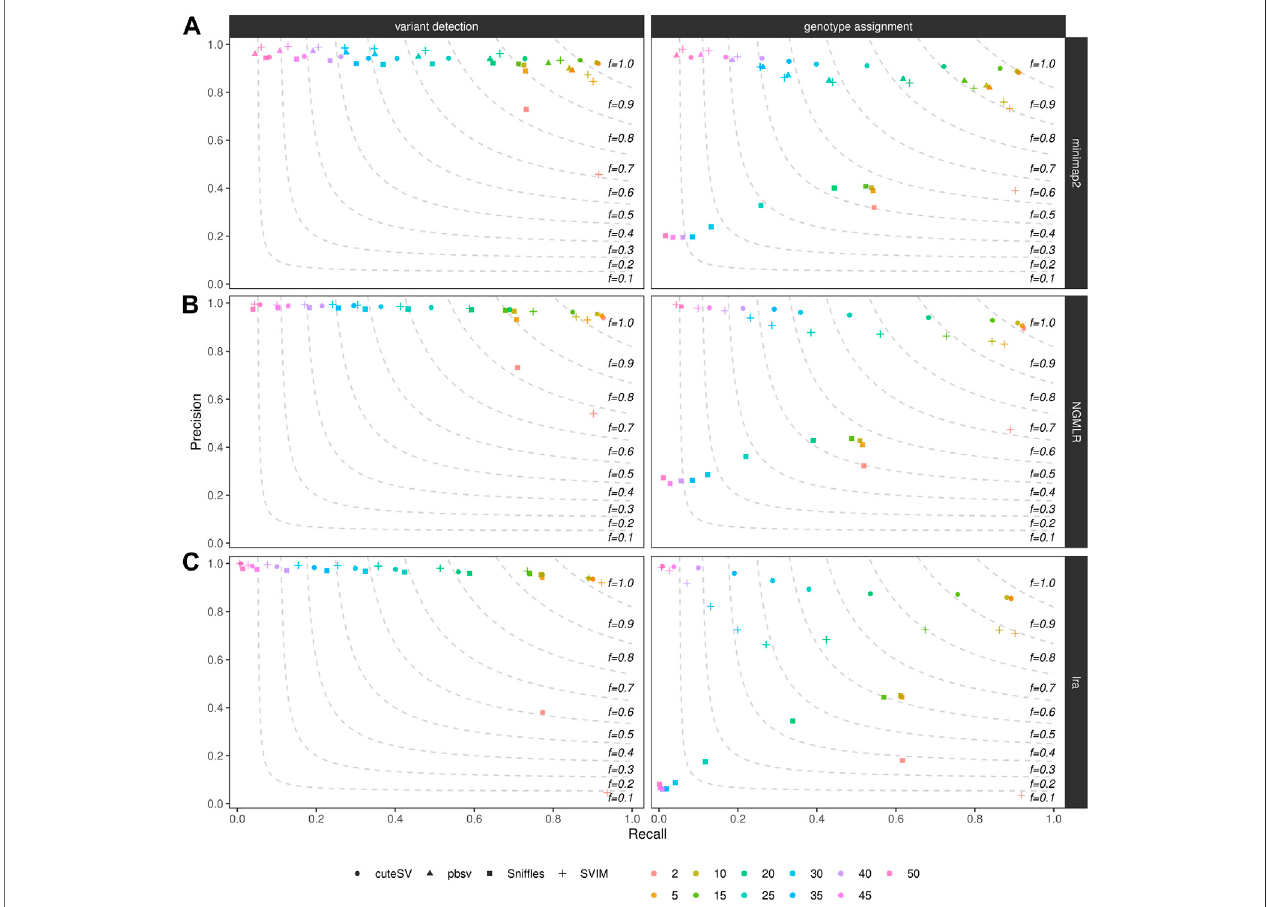
FIGURE 3 | Precision (y axis), recall (x axis) and F-score (dashed lines) of the SV callers Snif fl es (square symbol), SVIM (cross symbol), cuteSV (circle symbol) and pbsv(trianglesymbol)after minimap2(toppanels),NGMLR(midpanels)and lra(bottom panels)alignments.ResultsforbothSVcalling(left panels)andgenotyping(right panels) are reported. The plot shows the in fl uence of the number of reads minimally supporting a SV (2, 5, 10, 15, 20, 25, 30, 35, 40, 45, 50 – hue palette) on SV callers ’ performances for the NA24385